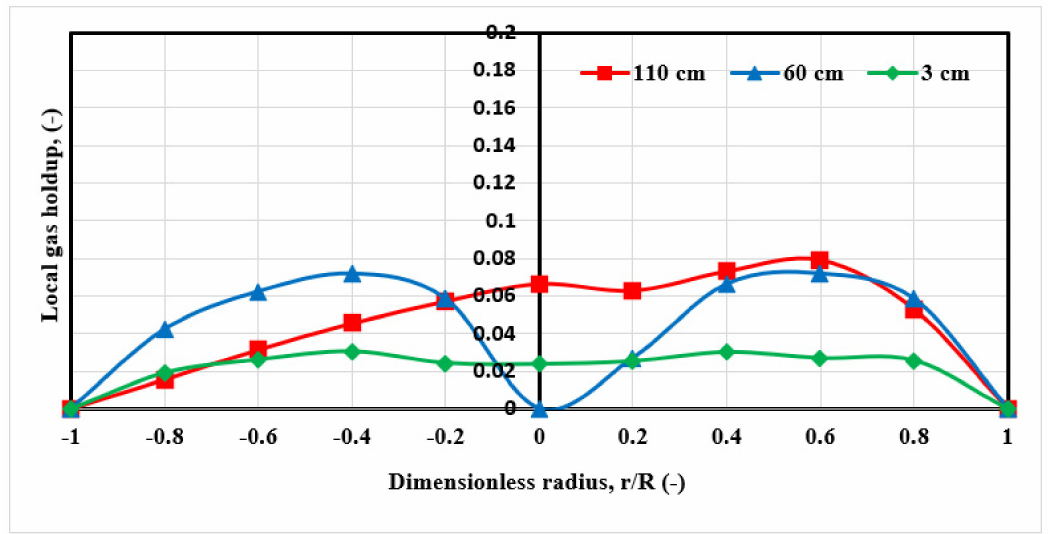
Figure 10. Profiles of local gas holdup at different height of split airlift reactor operated under 3 cm/s gas